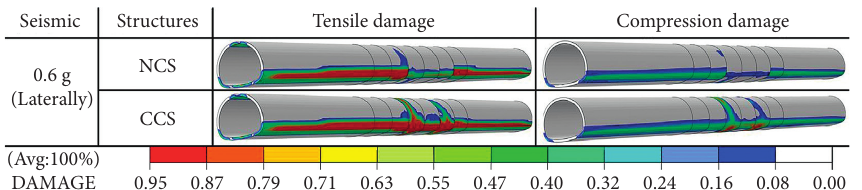
Figure 15: Lining damage distribution.